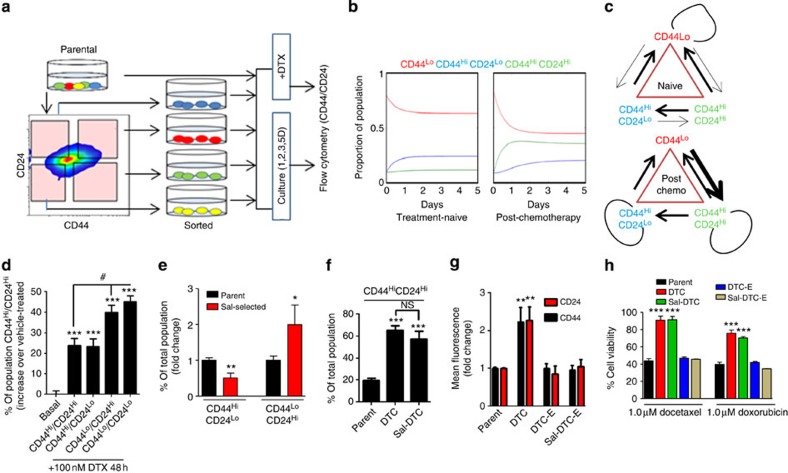
Modelling the induction of CD44HiCD24Hi cells.(a) Schematic shows experimental design used to derive mathematical parameters of population dynamics. Treatment of MDA-MB-231 breast cancer cells with 25 nM docetaxel (DTX) for 24 h induces phenotype plasticity rather than providing a selection pressure. In parallel, starting cells with different permutations and combinations of CD24 and CD44 expression levels were used, and the expression of CD44CD24 was monitored over defined time points. (b) Population dynamics modelling derived from experimental data indicates temporal kinetics of breast cancer cells in distinct compartments over 5 days (CD44Lo described as non-CSC). Left panel shows dynamics of distinct phenotypes under basal conditions, right panel demonstrates population dynamics under chemotherapy pressure. (c) Schematic shows subpopulation transition dynamics and predictive contribution of each population under chemotherapy pressure or basal state, saturated to equilibrium. Arrow weights denote prevalence of conversion. Loops indicate propensity to replicate or transition. (d) Treatment-naive 231-parental cells were sorted into CD44HiCD24Hi, CD44HiCD24Lo, CD44LoCD24Hi and CD44LoCD24Lo subpopulations, which were subsequently exposed to high-dose docetaxel (100 nM) for 48 h and re-analyzed by FACS for CD44HiCD24Hi subset expressed as % of total population. ‘Basal’ denotes the change in % of CD44HiCD24Hi subset in parental cells treated with vehicle. Data are mean±s.e.m. (ANOVA analysis, N=7, #P<0.05, *P<0.05 **P<0.01 versus basal group). (e) Depletion of intrinsic CSC population with salinomycin (5 μM, 48 h) was confirmed by reduction of a CSC (CD44Hi/CD24Lo) and enrichment of a non-CSC phenotype (CD44LoCD24Hi) expressed as fold change from vehicle-treated cells (error bars indicate s.e.m., N=5, *P<0.05 **P<0.01). (f) Chemo-tolerant cells generated from parent (DTC) and salinomycin-selected (Sal-DTC) MDA-MB-231 cells were analyzed by FACS for CD44Hi/CD24Hi, and results are expressed as % of total population (Data shown are mean±s.e.m., n=8, ANOVA analysis ***P<0.001, NS, not significant). (g) Graph shows mean fluorescent intensity (MFI) from FACS analysis of CD44 and CD24 expression in MDA-MB-231-parent, -DTC, -Sal-DTC or in a population of -expanded (E)-DTC and -Sal-DTC, demonstrating a reversal to parental phenotype when the chemotolerant cells are expanded over time (Data shown are mean±s.e.m. n=5, *P<0.05 **P<0.01). (h) Graph shows cell viability of each indicated population to docetaxel or doxorubicin, quantified by MTS cytotoxicity assay as % of viability in vehicle-treated control. All data shown are mean±s.e.m. from independent replicates (ANOVA analysis, n=8, ***P<0.001 versus parent cells).